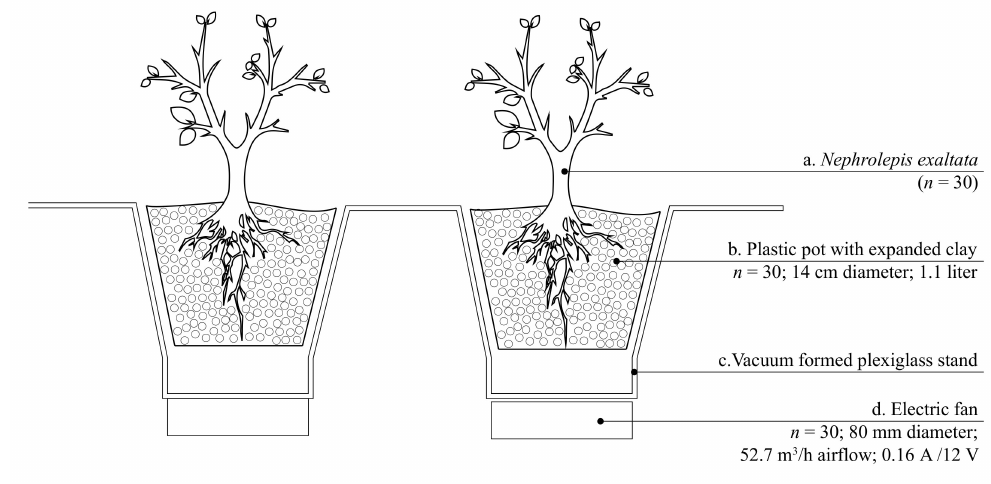
Figure 1. Prototype section scheme of the active plant-based